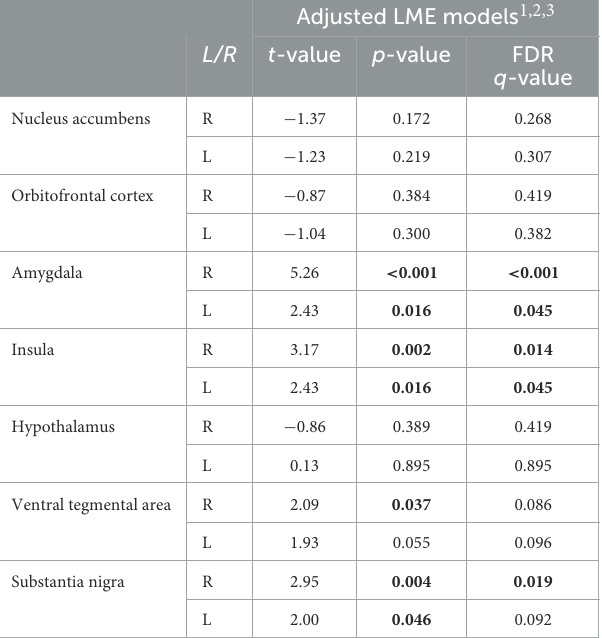
SUPPLEMENTARY TABLE 1 Sensitivity analysis with total screen exposure time as a